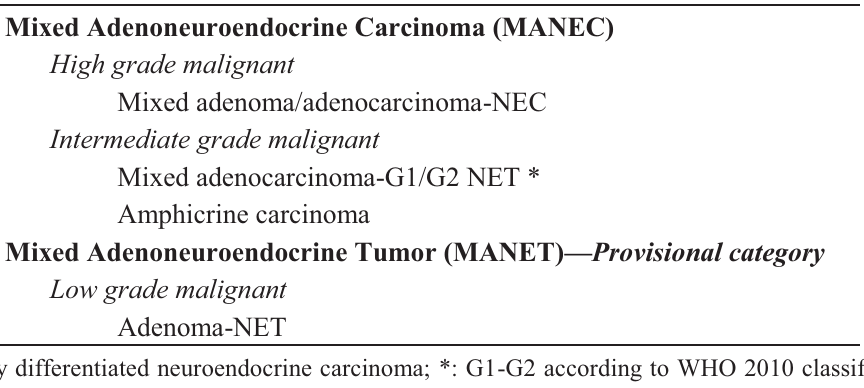
Table 1. Types of mixed exocrine-neuroendocrine neoplasms of the gastrointestinal tract, grouped according to the grade of